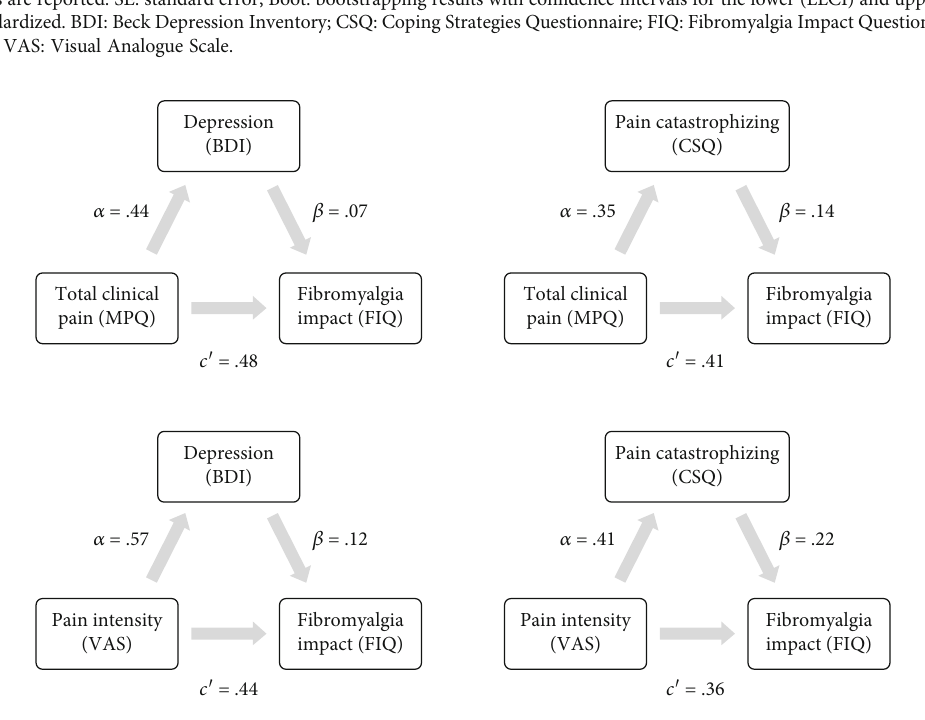
Figure 1: Statistical diagrams of partial mediation e ff ects of depression and pain catastrophizing between clinical pain (total and intensity) and FIQ score. Note: all coe ffi cients are standardized and signi fi cant at p < 0 : 01 ∗ . BDI: Beck Depression Inventory; CSQ: Coping Strategies Questionnaire; FIQ: Fibromyalgia Impact Questionnaire; MPQ: McGill Pain Questionnaire; VAS: Visual Analogue